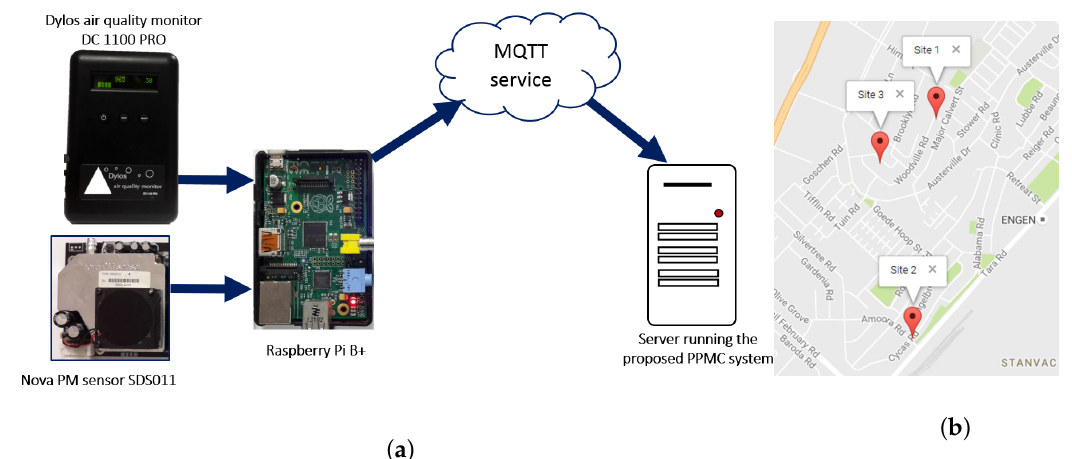
Figure 3. ( a ) Main hardware components; ( b ) Google map showing Site 1, Site 2 and Site